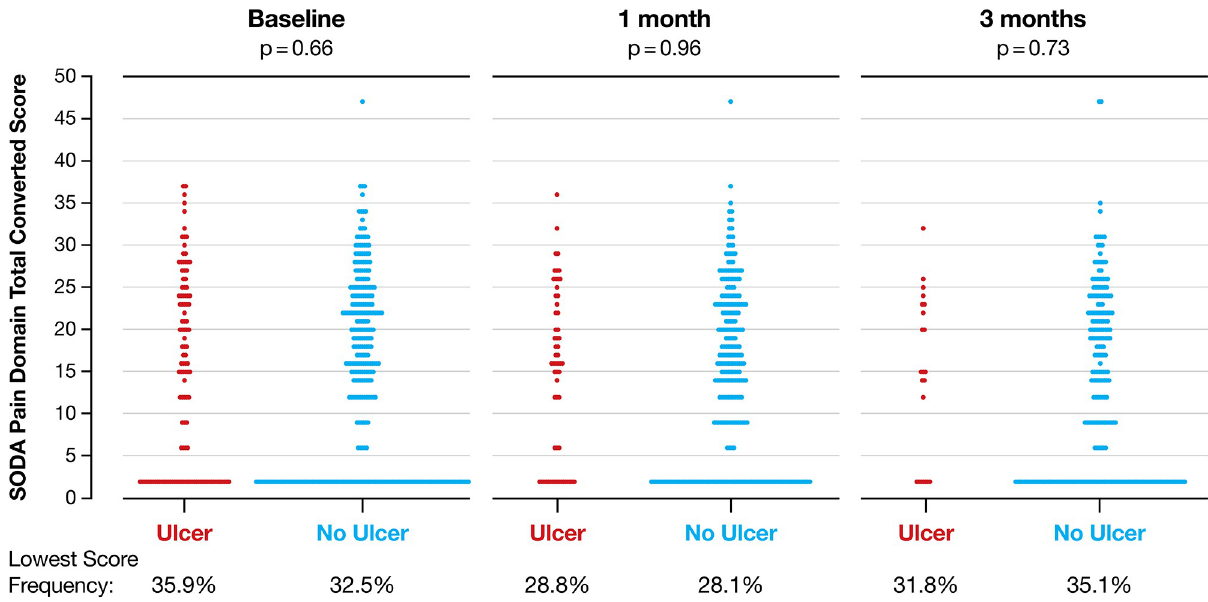
Fig 1. SODA pain intensity scores preceding ulcer development stratified by ulcer development at baseline, 1 month, and 3 months of treatment with naproxen. Data are number of patients. SODA, Severity of Dyspepsia Assessment.